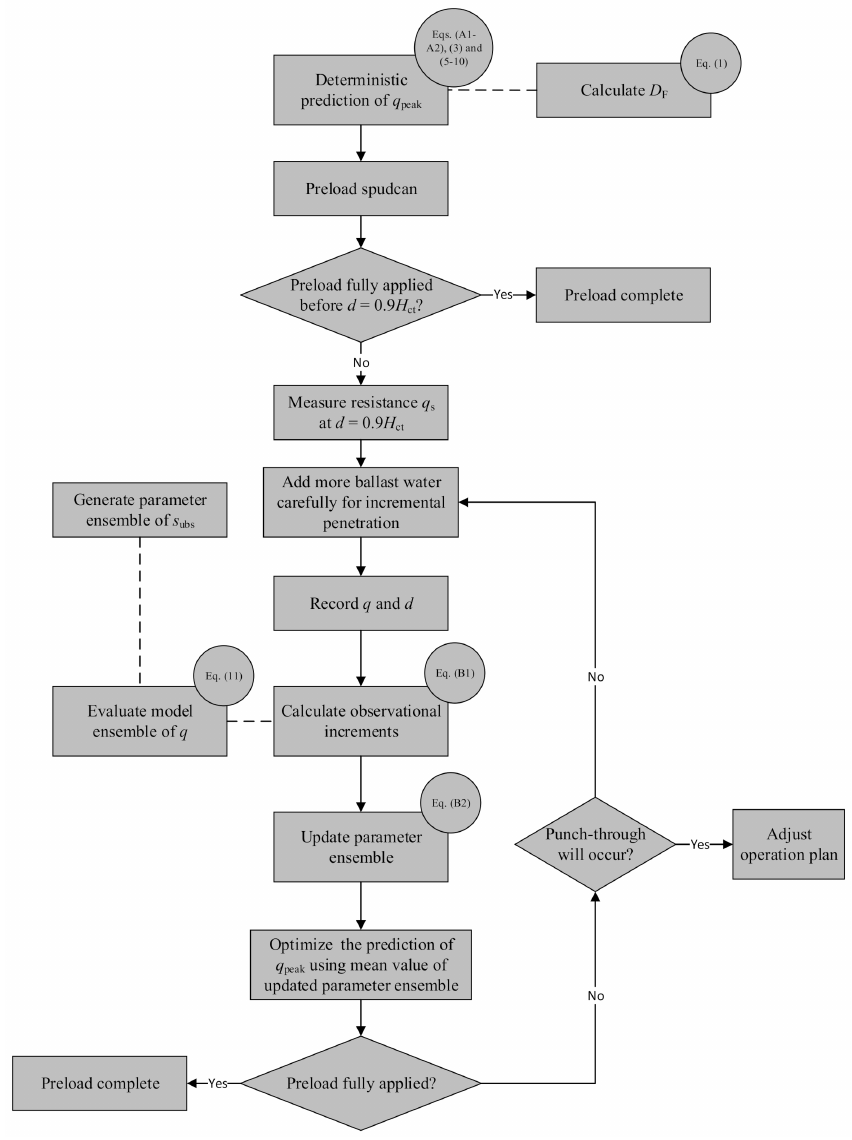
Figure 8. Flowchart of proposed assessment procedure for optimized estimation of q peak